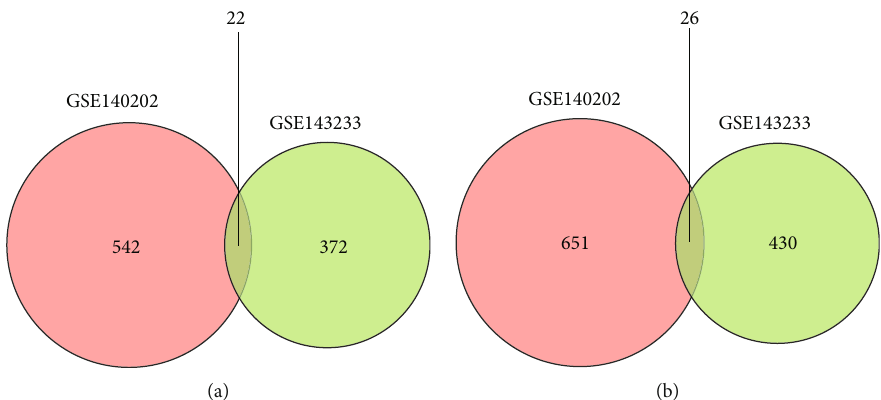
Figure 2: Venn diagram of common DEGs in GSE140202 and GSE143233. (a) A Venn diagram of common upregulated DEGs in GSE140202 and GSE143233 is shown. (b) A Venn diagram of common downregulated DEGs in GSE140202 and GSE143233 is